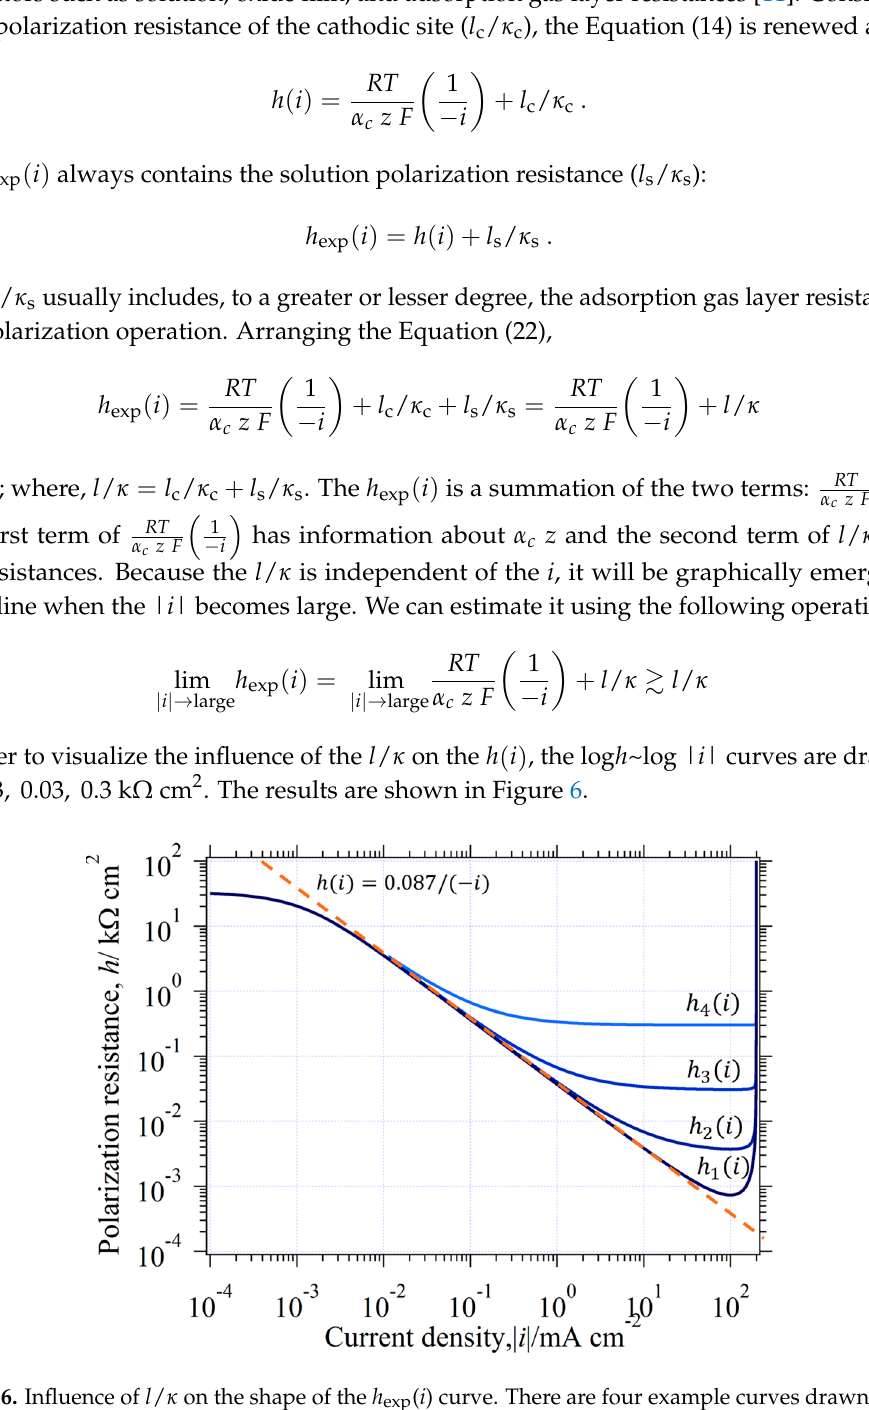
(cid:16) (cid:17)(cid:16) (cid:17) 1 1 . − i 1 + i /200